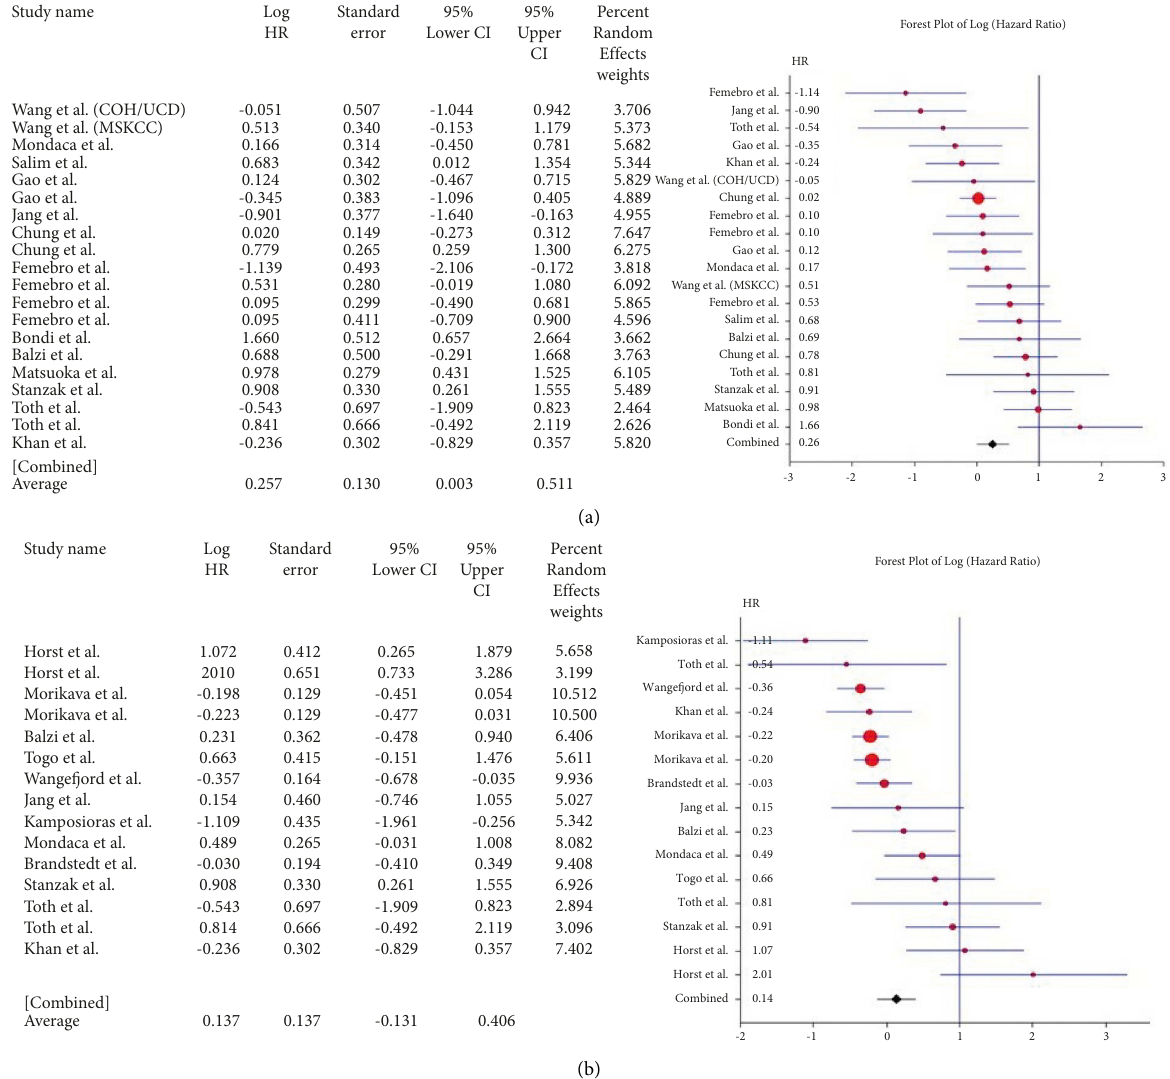
Figure 2: Forest plot of β -catenin gene and overall survival in CRC (a). Forest plot of β -catenin gene and disease-free survival in CRC (b).